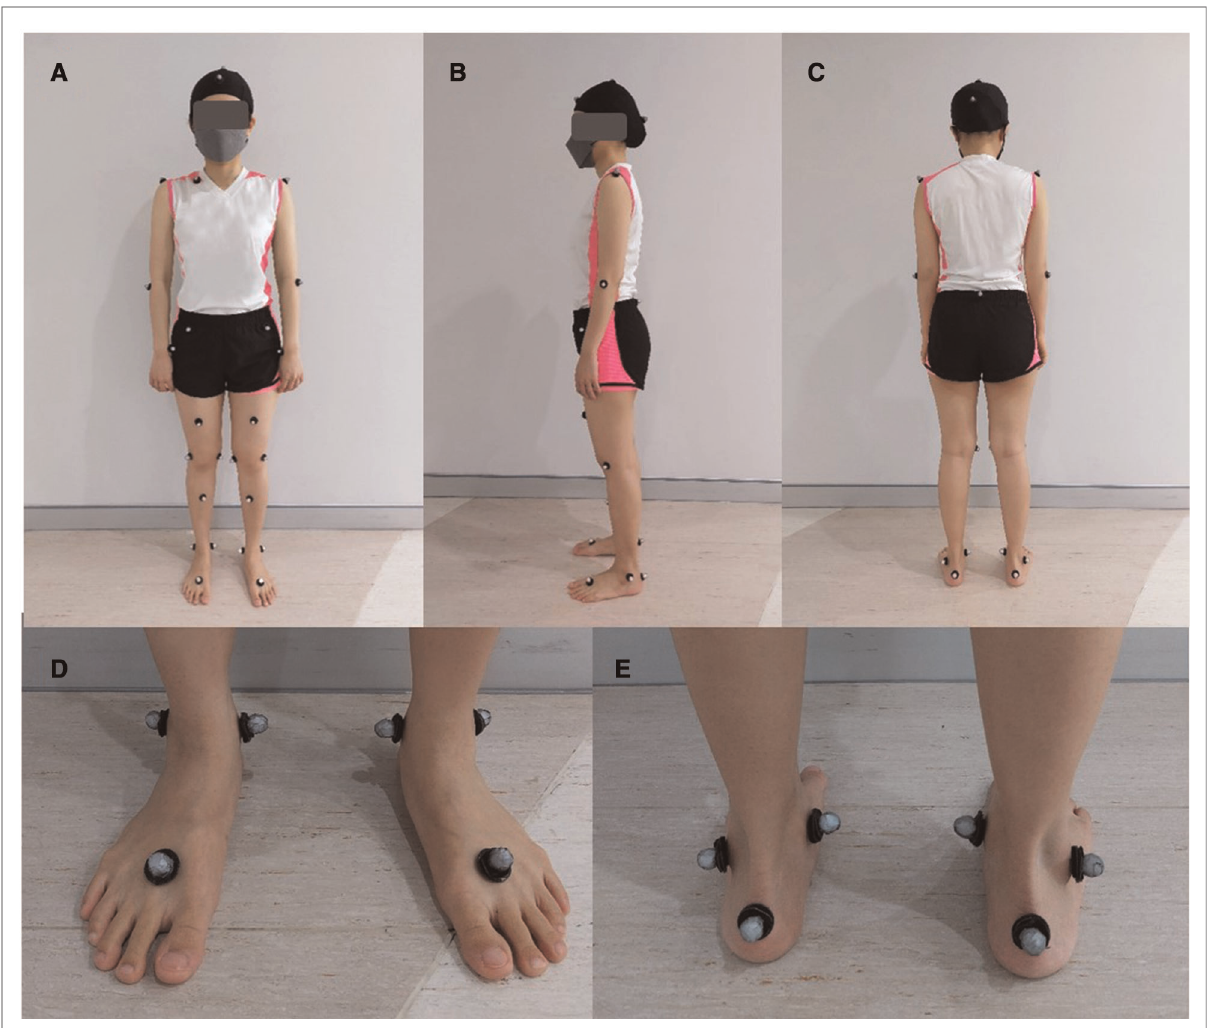
FIGURE 1 The modi fi ed Helen Hayes technique with 29 re fl ective markers included medial knees, ( A ) front, ( B ) side, and ( C ) back; and medial malleoli of the ankles, ( D ) front, and ( E )